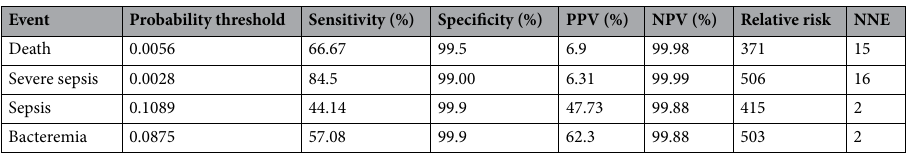
Table 3. Alert thresholds and model